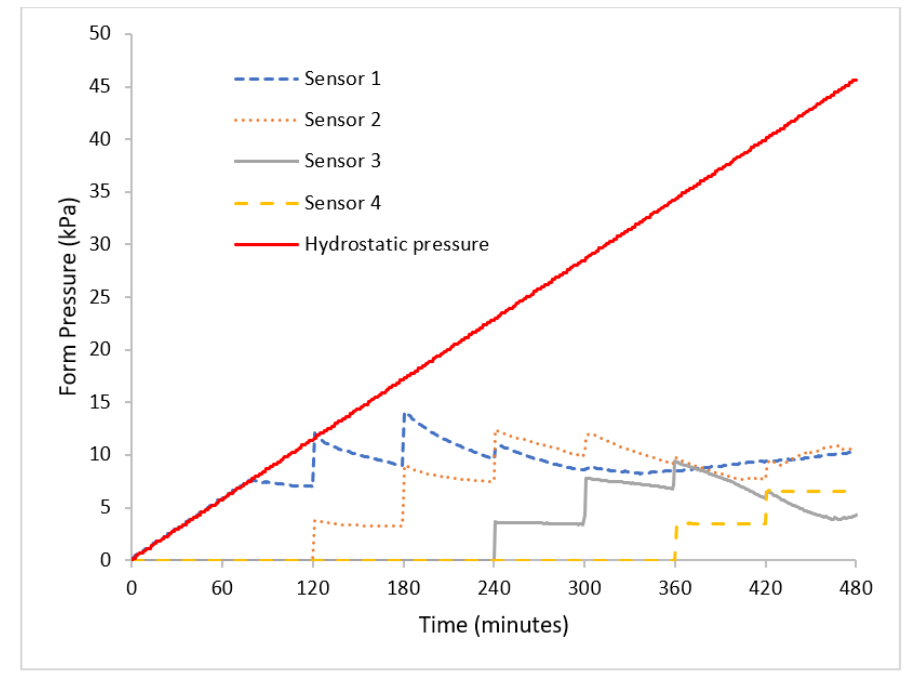
Figure 3. Pressure monitoring over time for 0.25 m/h casting rate.